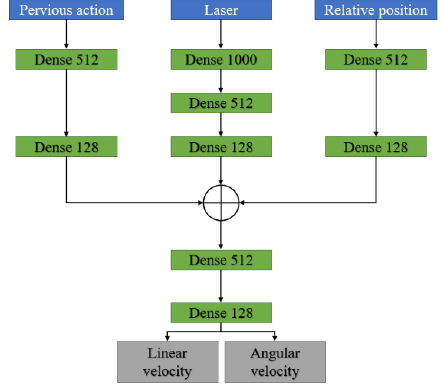
Figure 7. Proximal policy optimization (PPO) network structure.